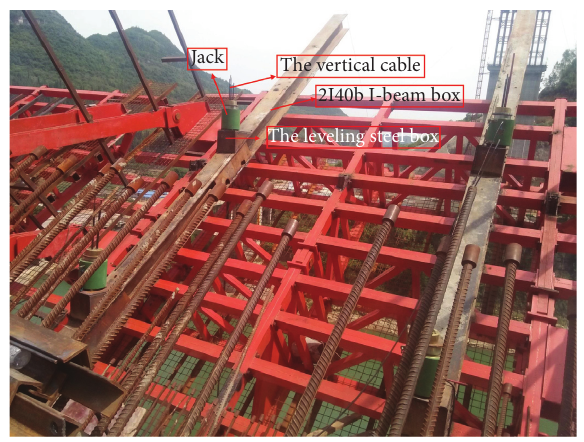
Figure 18: Layout of the tension end of the hanging basket load test.